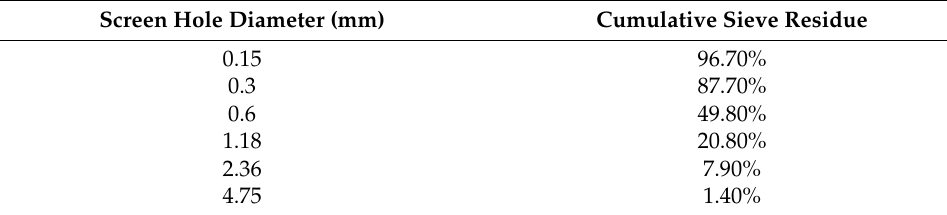
Table 2. Sieve classification of